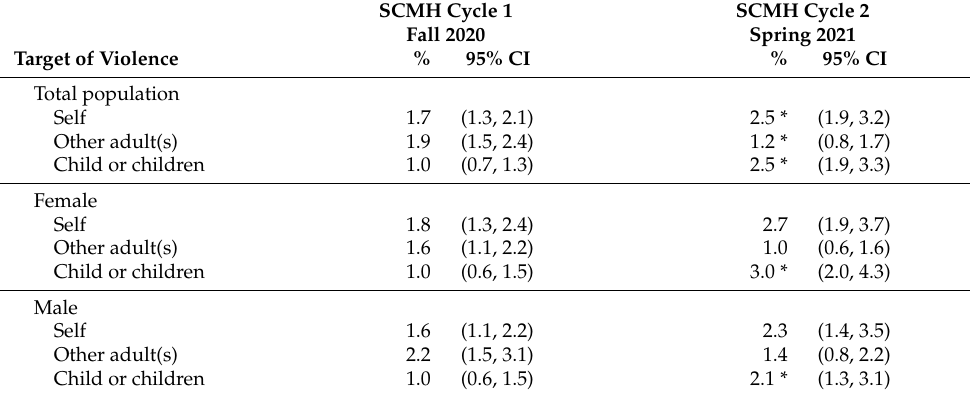
Table 3. Prevalence of concern about violence in individuals’ own homes, by gender and target of violence, population aged 18 or older, Canada, 2020 and